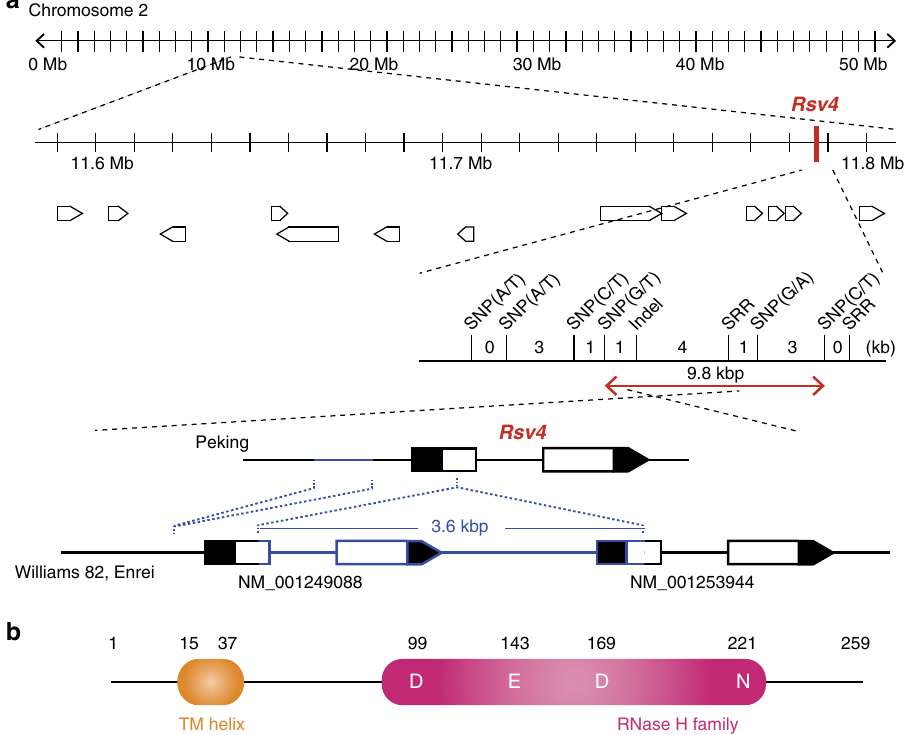
Fig. 1 Positional cloning of Rsv4 . a Fine mapping of Rsv4 . The gene structures in the Peking, Williams 82, and Enrei genomes are shown at the bottom. Indels are indicated in blue. Black boxes are untranslated regions. b Predicted Rsv4 protein structure. Amino acid positions of the transmembrane (TM) helix and active-site residues of the RNase H family domain are